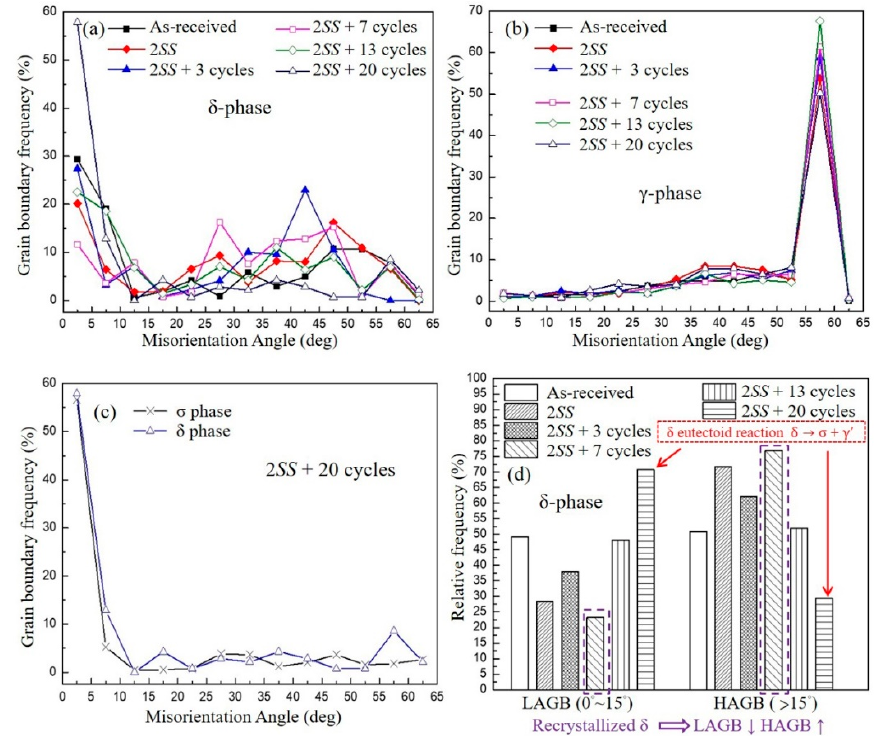
Figure 6. Distribution of grain boundary misorientation angles at different thermal cycles for ( a ) δ phase; ( b ) γ phase; ( c ) the condition of 2 SS + 20 cycles; ( d ) a statistical histogram of delta ferrite grain boundary angle classification.